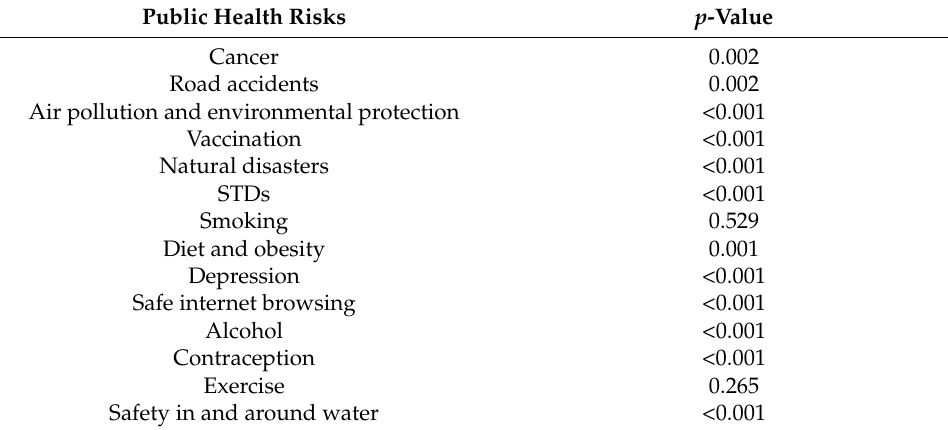
Table 2. Chi-square tests regarding the importance of public health risks by sex (importance defined as “Very important”, “Moderately important”, “Slightly important”, “Not important”, “Do not know/No answer”).